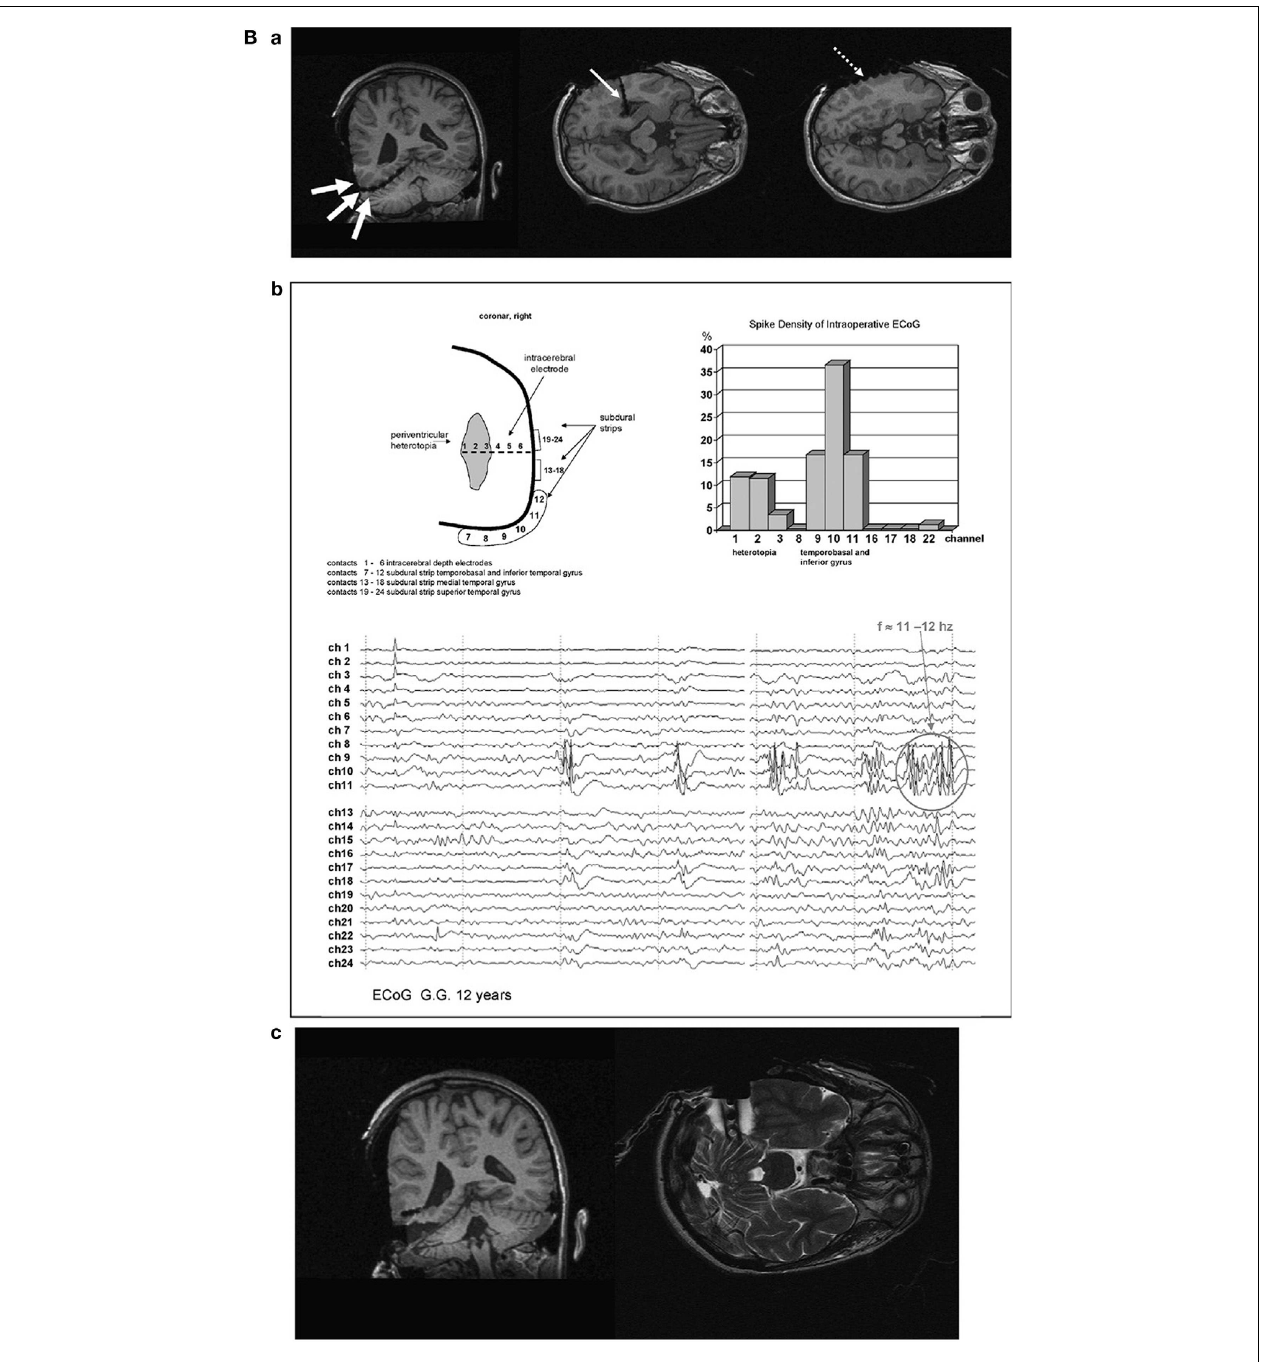
corresponding spike density distribution is shown (upper right).The neocortex shows predominant spike wave activity and 11–12s − 1 polyspikes during intraoperative ECoG. (c) Intraoperative MR-imaging after cortical resection of MSI-focus No. II (with platinum-electrodes still in situ